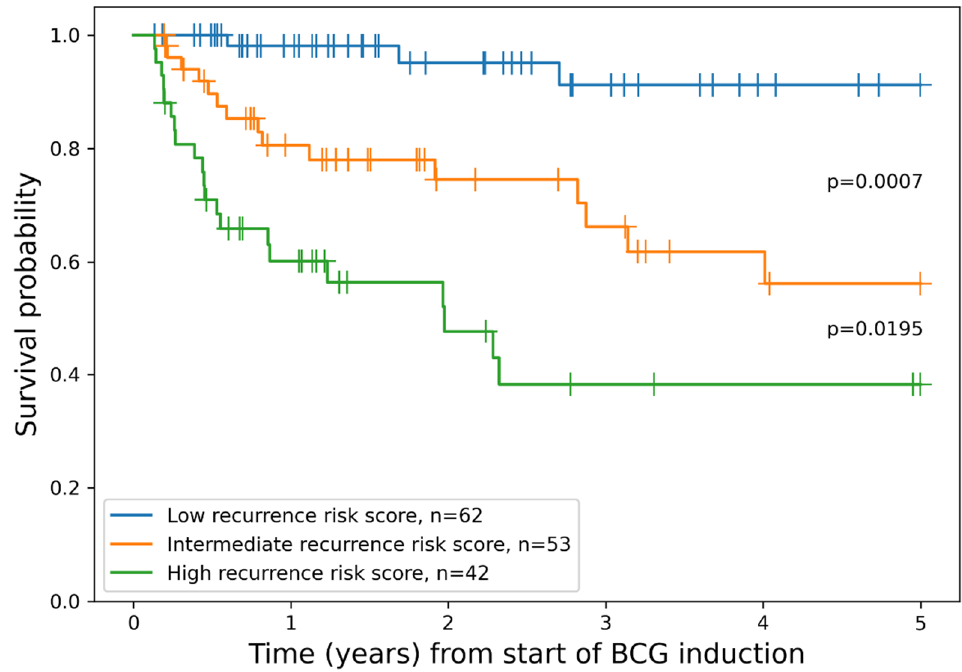
Figure 3. Kaplan–Meier plot of RFS grouped by combined model for patient risk assessment.